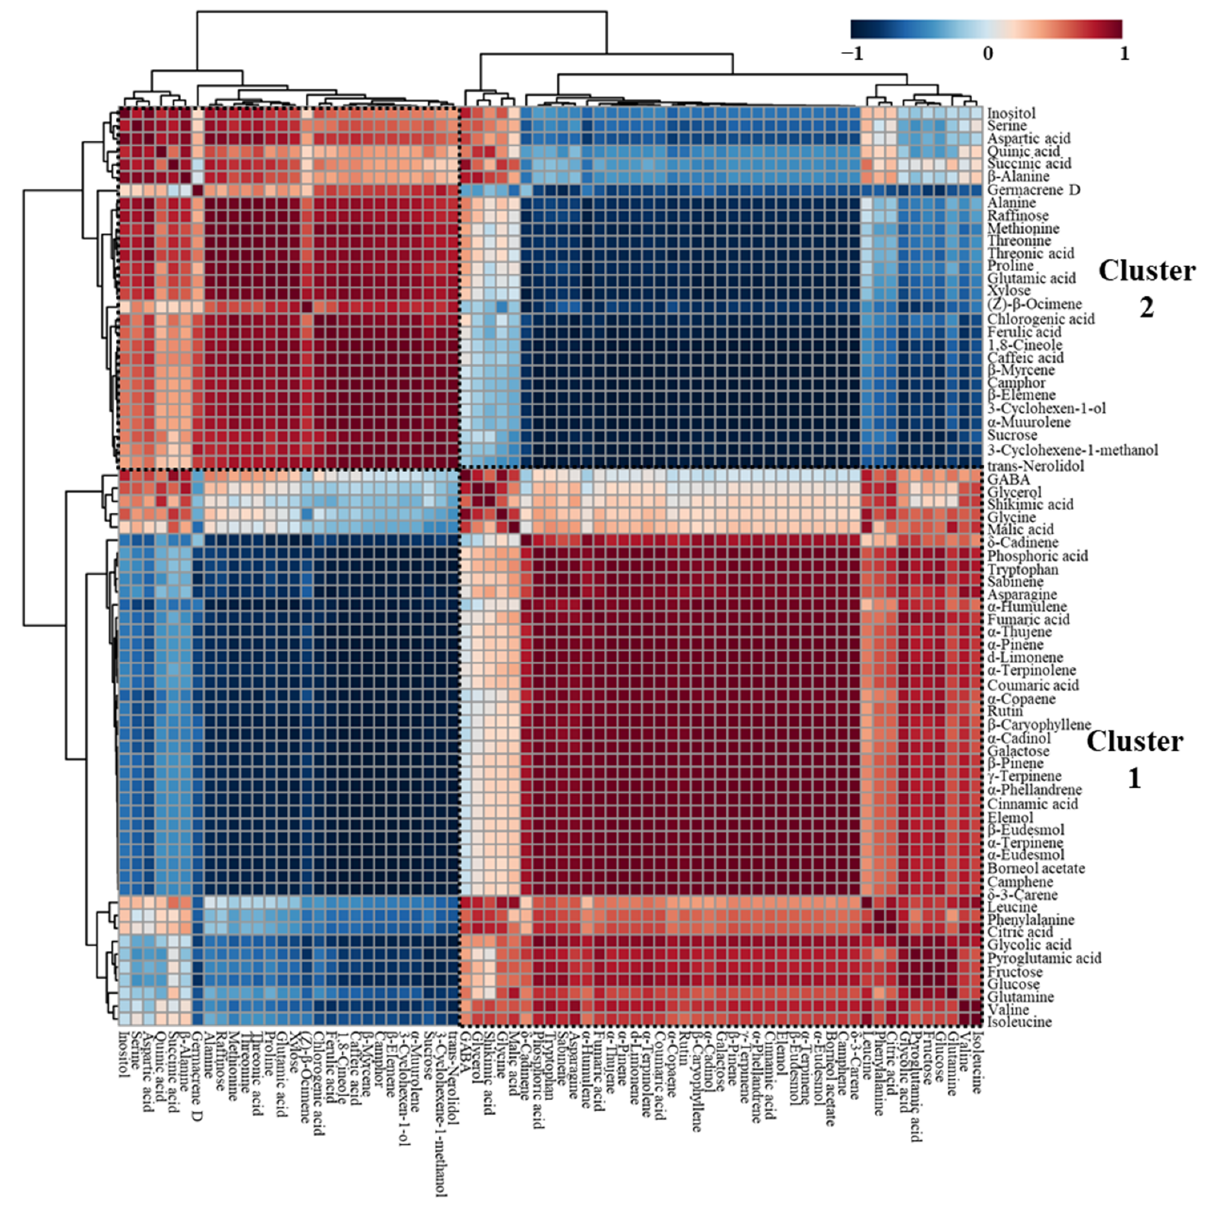
Figure 2. Correlation matrix of 71 metabolites from white and violet Magnolia flower buds. Each square indicates the Pearson’s correlation coefficient for a pair of compounds, and the correlation coefficient is represented by the shade of blue or red, as indicated on the colour scale.